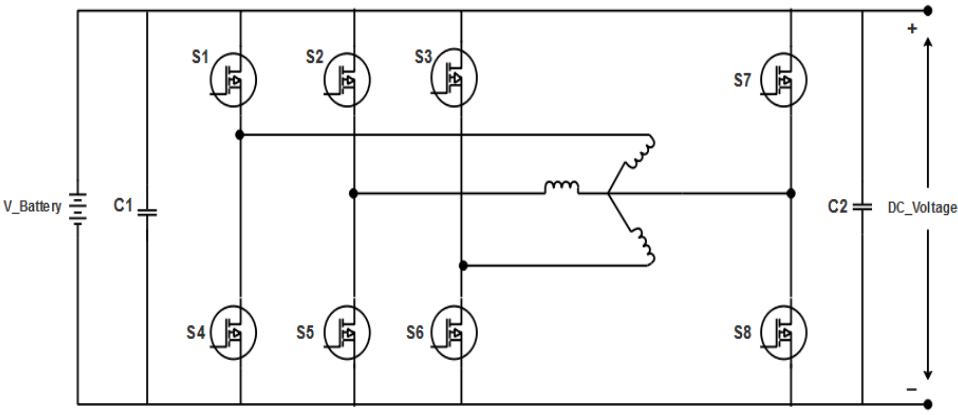
Figure 1. Circuit diagram of the bidirectional converter.